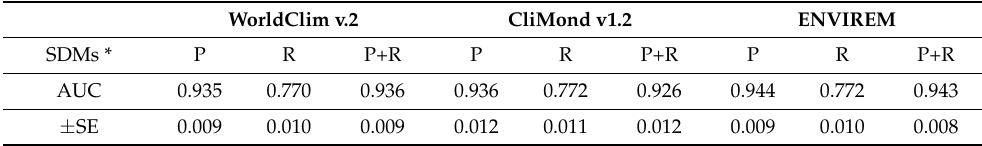
Table 1. Measures of accuracy of produced SDMs. *—SDMs built for P. robiniella (P), R. pseudoacacia (R) and P. robiniella incorporating the habitat suitability raster for R. pseudoacacia